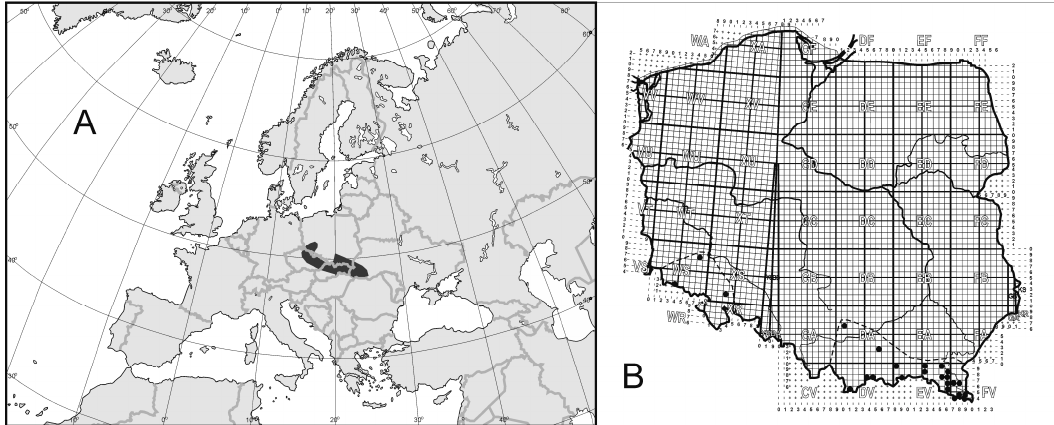
Figure 2. Range of Trachytes minima : ( A ) in Europe, ( B ) in Poland; black dots—recorded occurrences of the species, dotted line—northern range